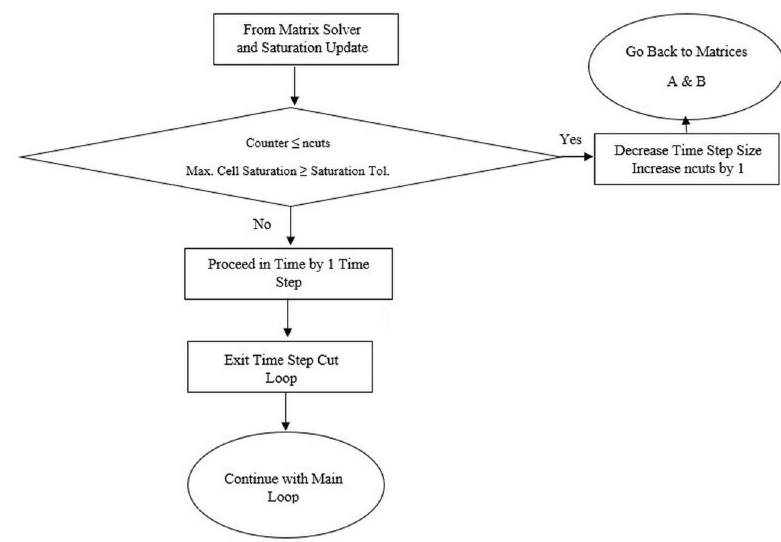
Fig. 5 Time step cut flowchart